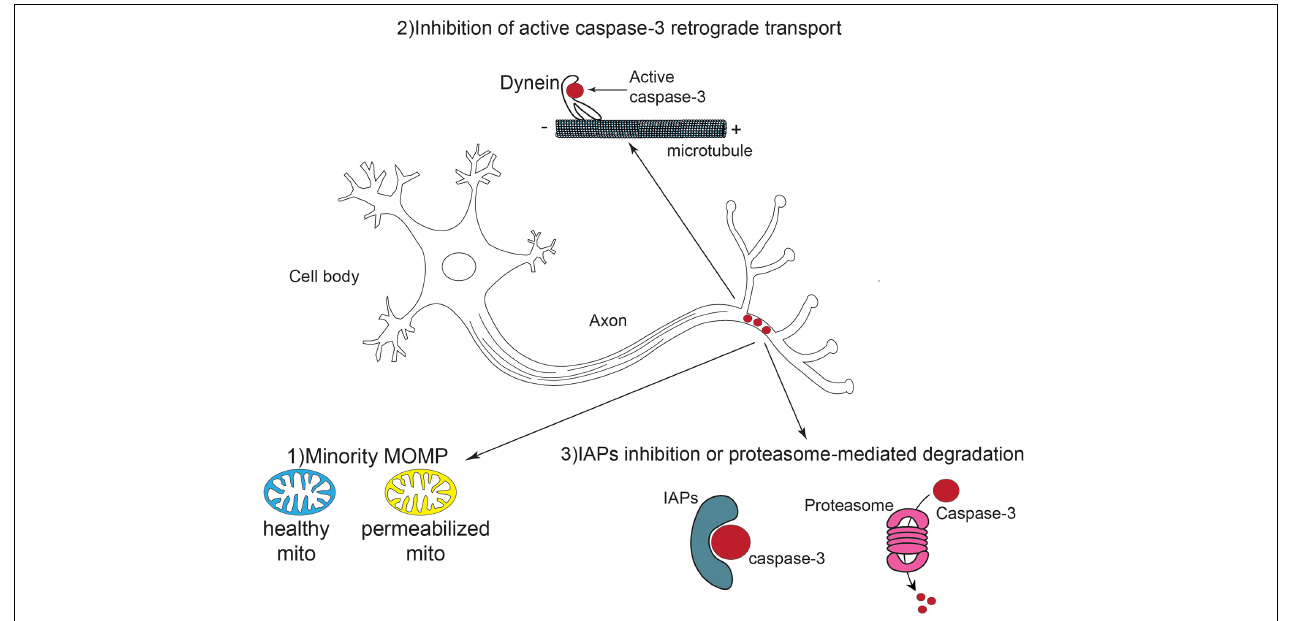
FIGURE 3 | Schematic representation of local caspase activation and potential regulation pathways in neural development. Caspase-3 is activated locally and transiently in the axons of developing and mature neurons. This activation might result from a phenomenon called “minority MOMP” in which only a subpopulation of mitochondria is permeabilized while the others remain healthy. The retrograde transport of active caspases via dynein is also inhibited. Finally, IAPs can suppress caspase-3 activity through direct inhibition or proteasome mediated degradation.